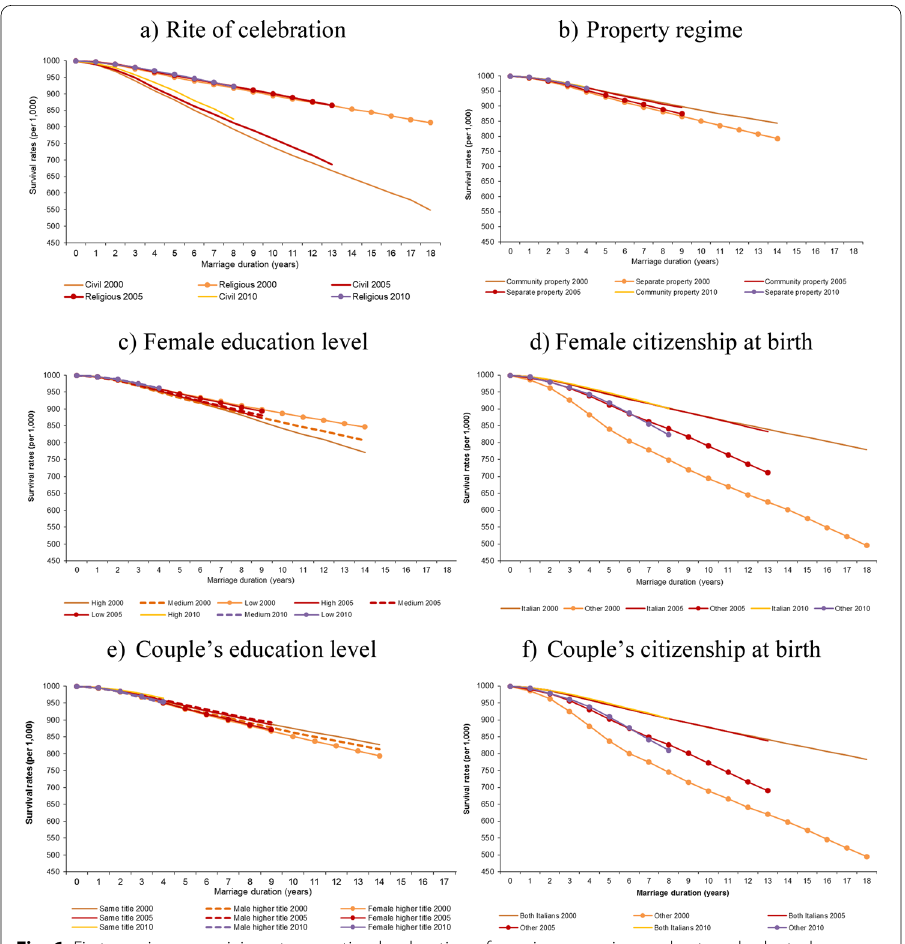
Fig. 6 First marriages surviving at separation by duration of marriage, marriage cohort, and selected characteristics (survival rates per 1000 marriages), Italy. Source Author’s elaboration of Istat data on marriages and